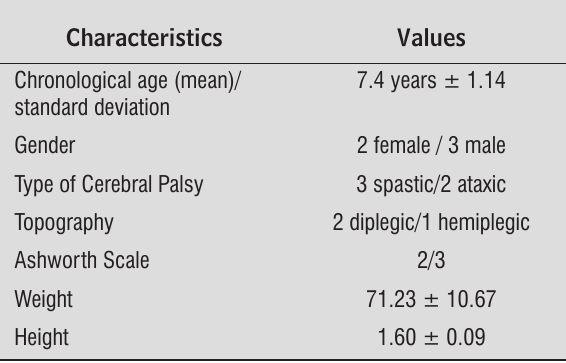
Table 1 - Characterization of the sample (n = 5) in relation to chronological age, gender, type and topography of cerebral palsy and degree of muscle tone according to the Ashworth Scale Characteristics Values